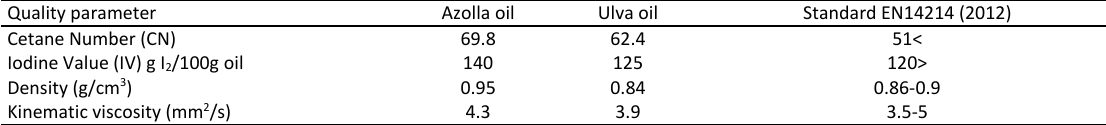
Table 8: Biodiesel properties of A. filiculoide and U. fasciata and the EU standards for biodiesel